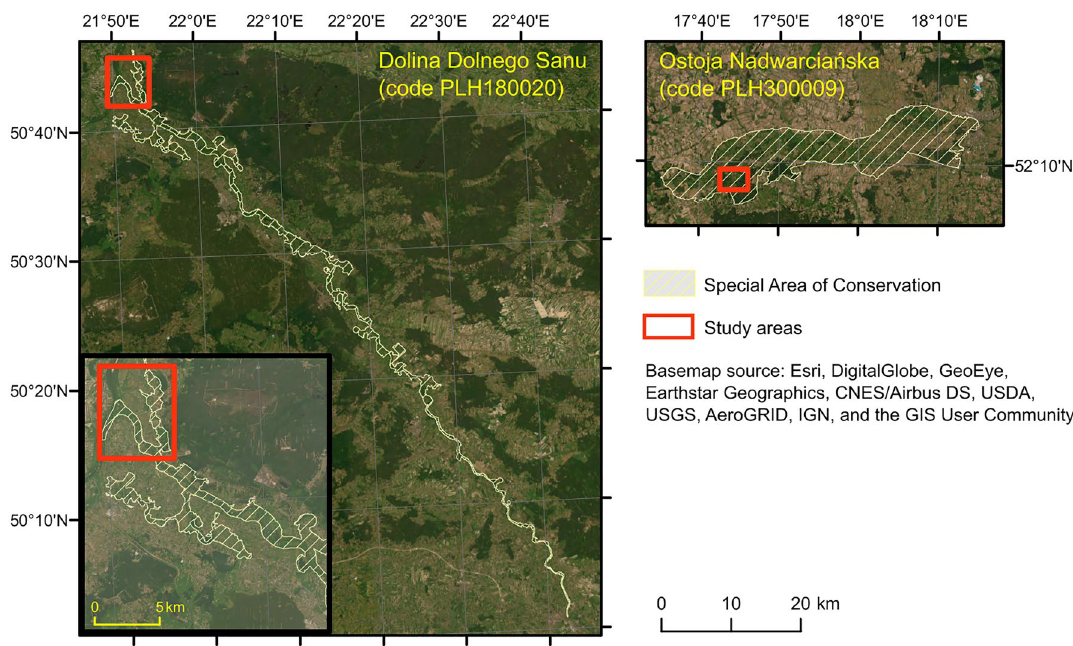
Figure 5. The region covered by Special Areas of Conservation Natura 2000 area, and study areas NA1 and SA1 chosen for visualisation. Figure created by the authors using ArcMap 10.6.1 software (https:// suppo rt. esri. com/ en/ Produ cts/ Deskt op/ arcgis- deskt op/ arcmap).